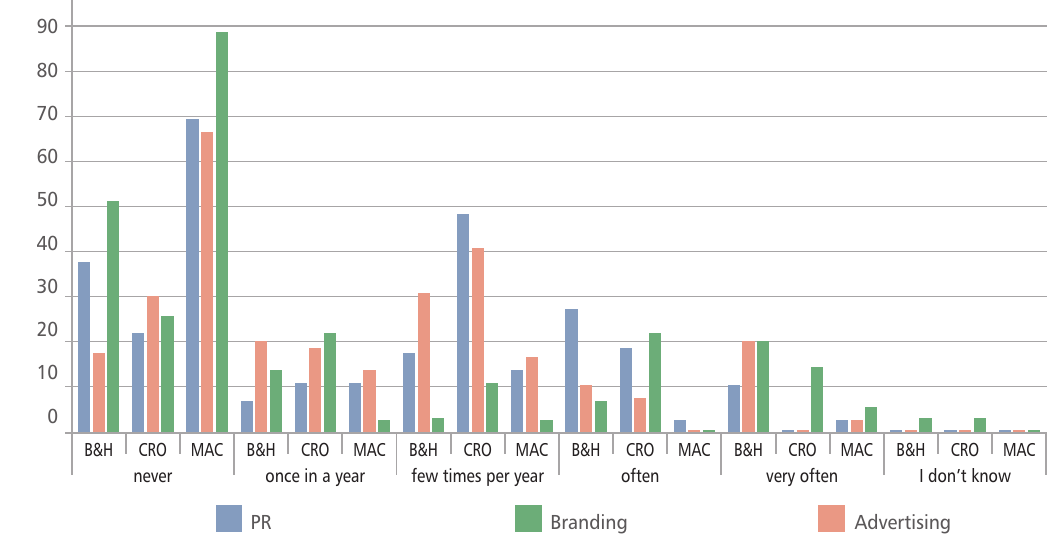
FIGURE 3. The use of marketing tools in % by country (sample size: 30 companies in B&H; 71 companies in Croatia; 36 companies in Macedonia). Note: Because of the minor differences in questionnaires used in analyzed countries, data for Serbia are not shown in the figure, but only explained in the text.